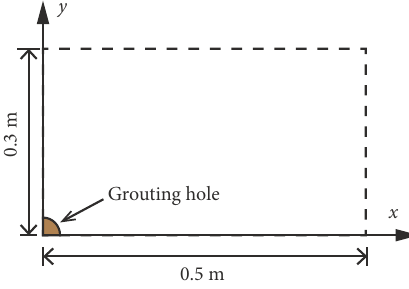
Figure 17: Calculation region in Case